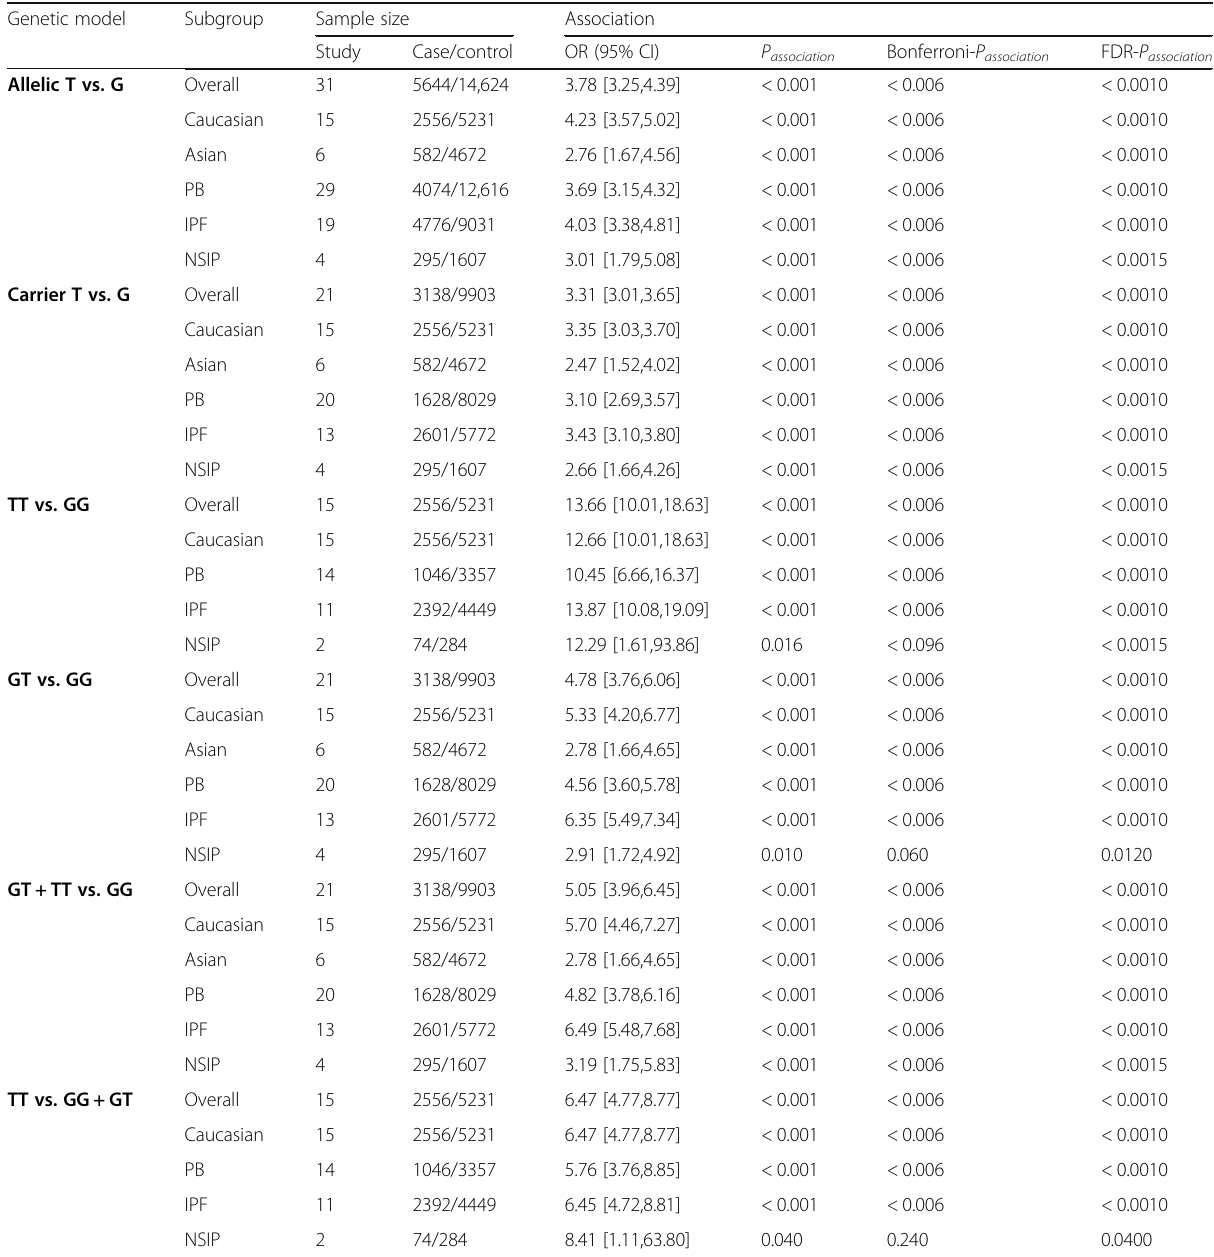
Table 4 Pooling data regarding the association between MUC5B rs35705950 and pneumonia risk Genetic